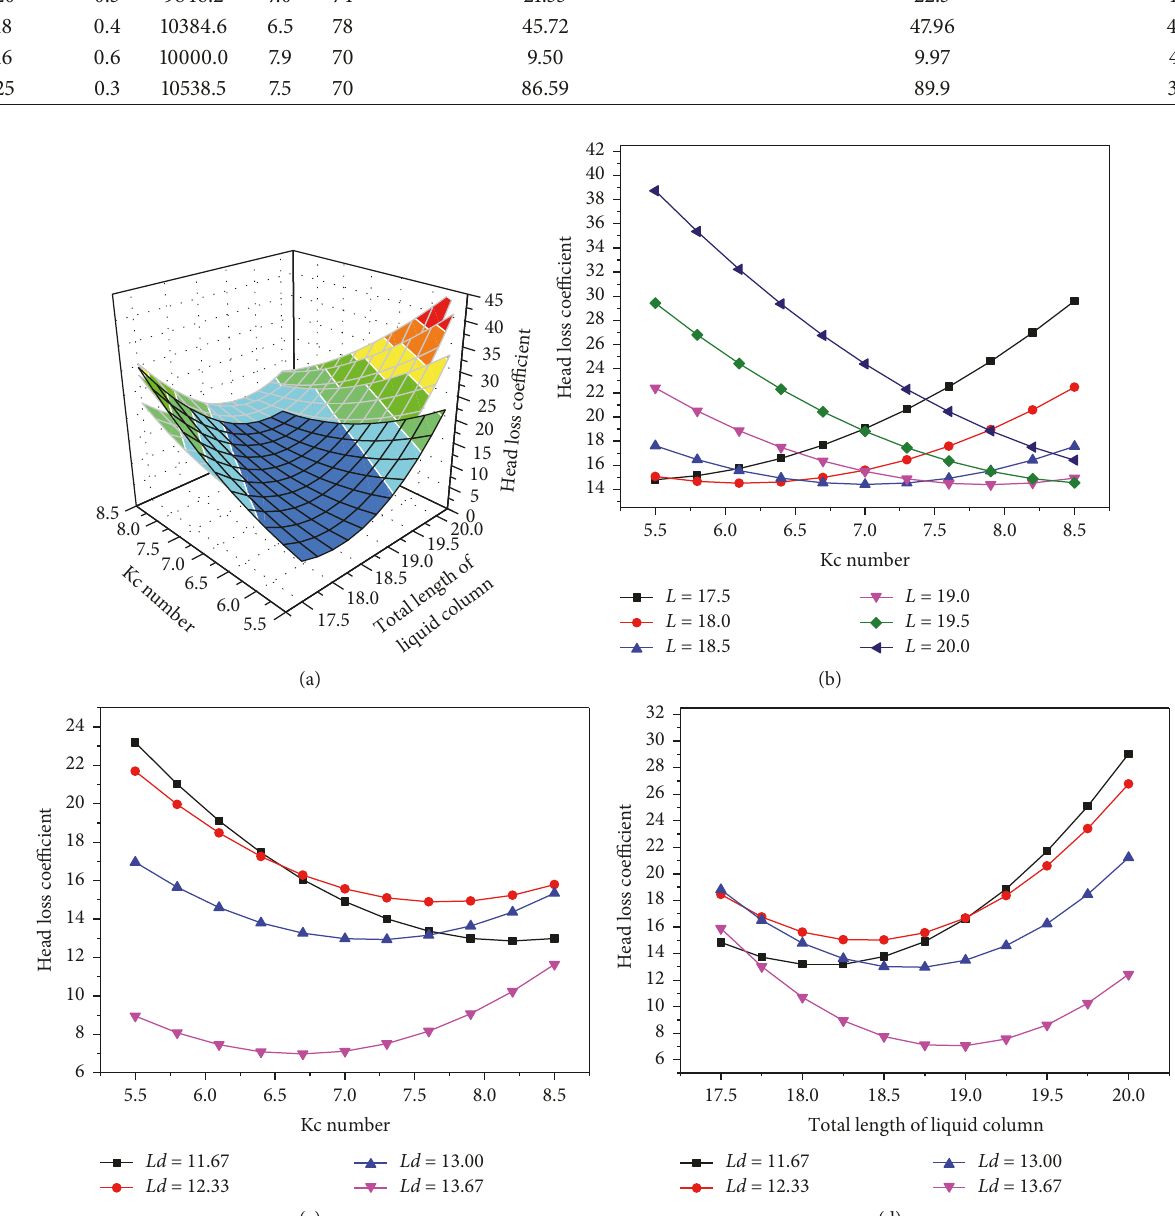
Figure 8: Relation schema of Kc number–total length of liquid column–horizontal length of liquid